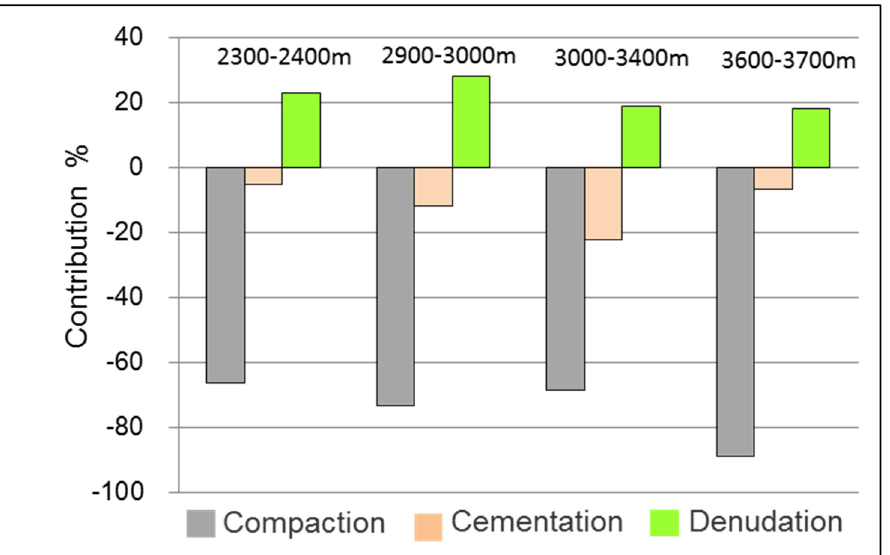
Figure 17. Contribution to reservoirs porosity by compaction, cementation, and denudation in the Pinghu area.